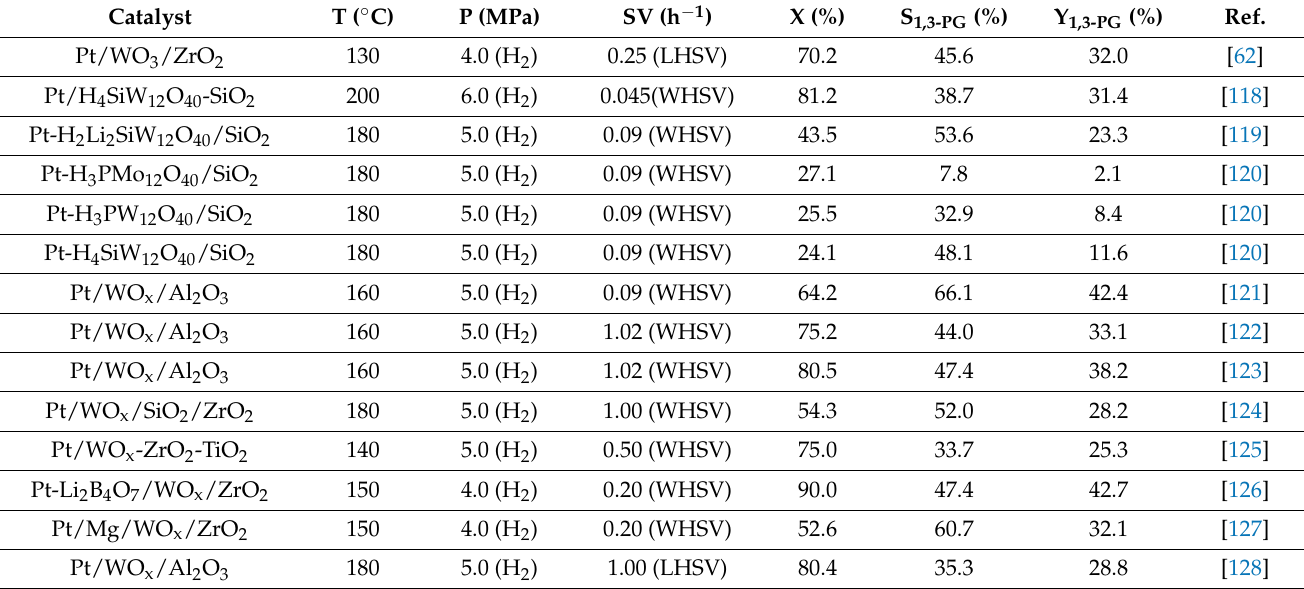
Table 5. The hydrogenolysis of glycerol to 1,3-PG using Pt catalysts operating in liquid phase continuous flow